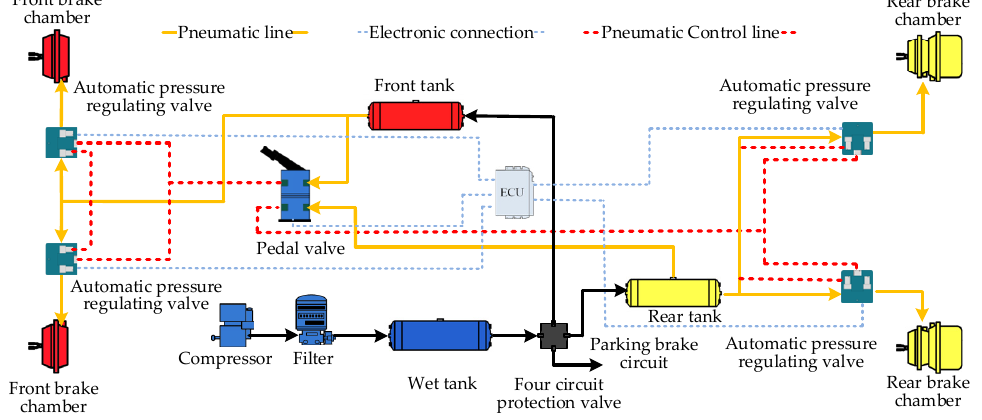
Figure 1. Principle drawing of the ECPBS for driving automation in commercial